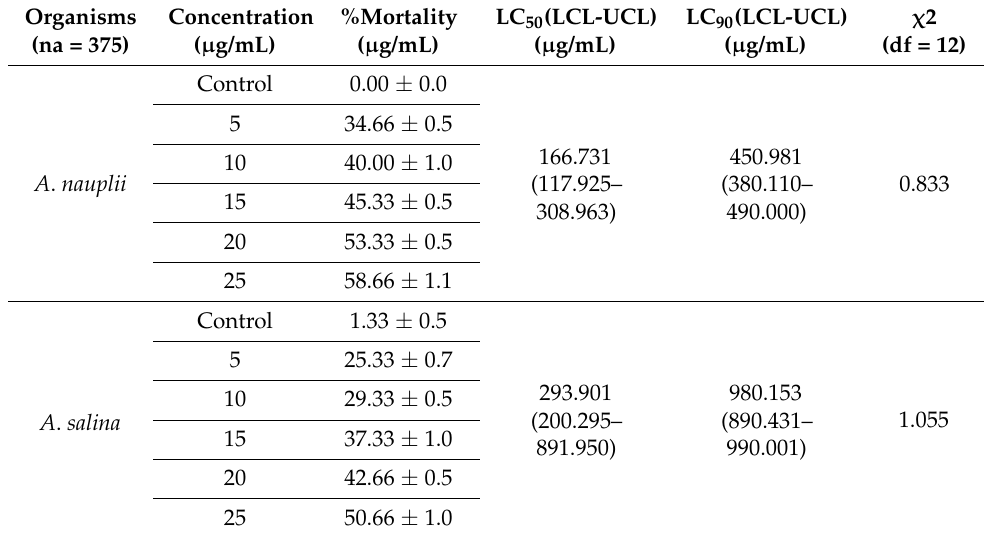
Table 3. Non-target effect of green cluster copper nano-pesticide synthesized from entomopathogenic fungi M . robertsii against A . nauplii and A . salina at 24 h after